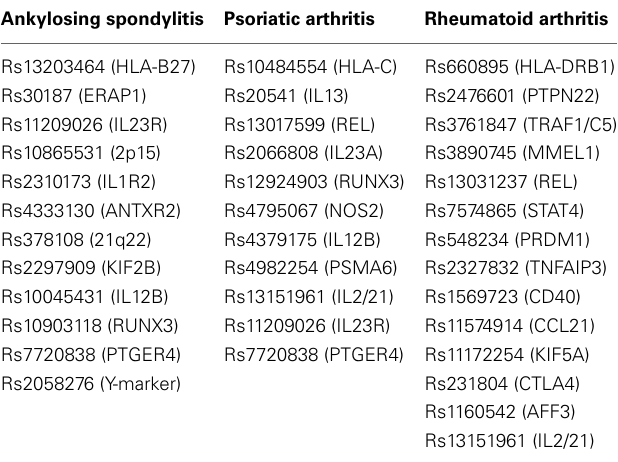
Table 1 | Illustration of machine learning methods applied to genetic data: feature selection.